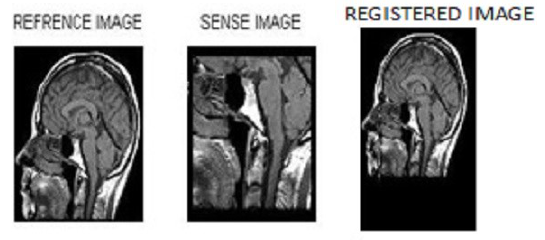
Fig 11. Image Registration for Head CT with scale. Estimated Horizontal movement 103,Vertical movement 44, Scale